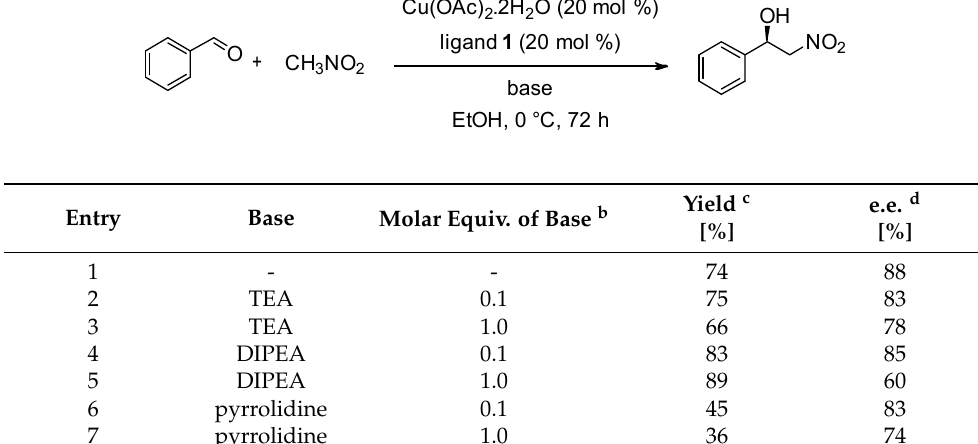
Table 3. Influence of a base addition on the reaction of benzaldehyde with nitromethane a catalyzed by the copper(II) complex of ligand 1 .